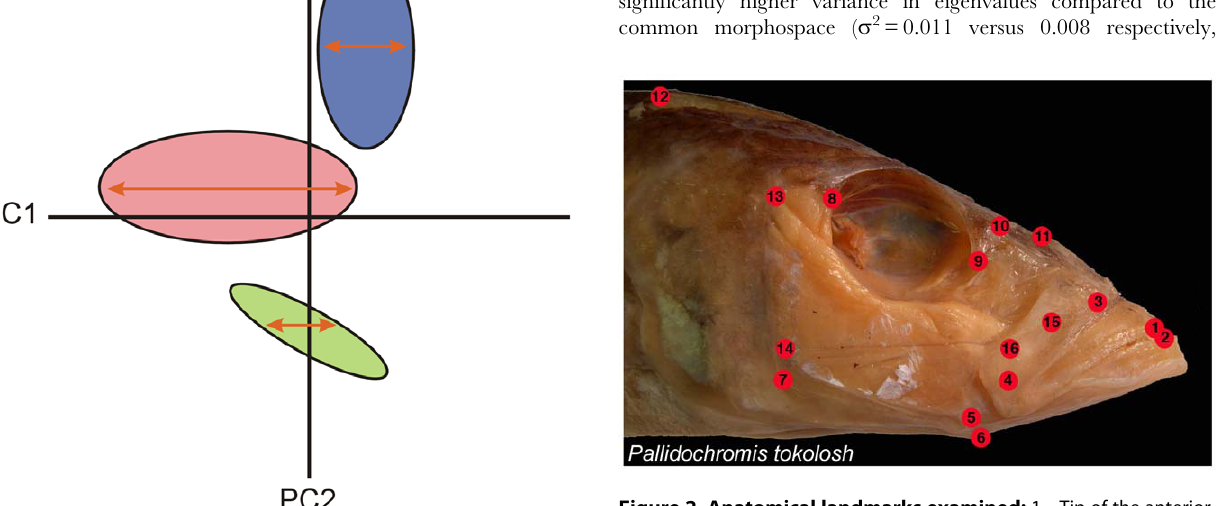
Figure 2. Anatomical landmarks examined: 1=Tip of the anterior- most tooth on the premaxilla; 2=Tip of the anterior-most tooth on the dentary; 3=Maxillary-palatine joint (upper rotation point of the maxilla); 4=Maxillary-articular joint (lower point of rotation of the maxilla); 5=Articular-quadrate joint (lower jaw joint); 6=Insertion of the interopercular ligament on the articular (point at which moth opening forces are applied); 7=Posterio-ventral corner of the preopercular; 8=Most posterio-ventral point of the eye socket; 9=The most anterio- ventral point of the eye socket; 10=Joint between the nasal bone and the neurocranium; 11=Posterior tip of the ascending process of the premaxilla; 12=Dorsal-most tip of the supraoccipital crest on the neurocranium; 13=Most dorsal point on the origin of the A1 division of the adductor mandibulae jaw closing muscle on the preopercular; 14=Most dorsal point on the origin of the A12 division of the adductor mandibulae jaw closing muscle on the preopercular; 15=Insertion of the A1 division of the adductor mandibulae on the maxilla; 16=Inser- tion of the A2 division of the adductor mandibulae on the articular